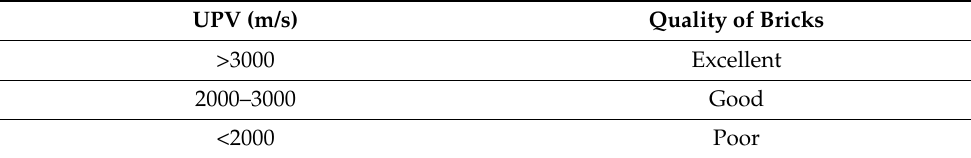
Table 2. Proposed brick quality assessment criteria based on UPV.